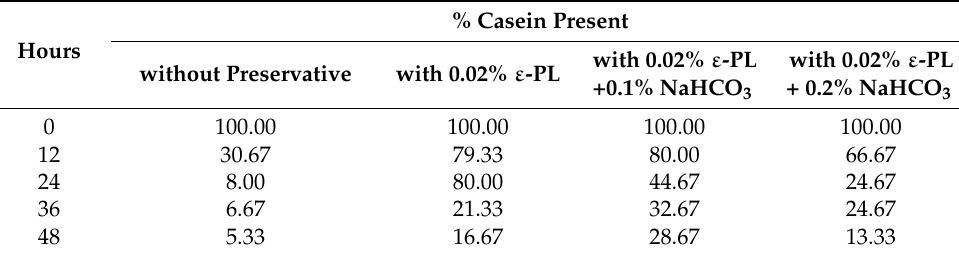
Table 5. Effect of ε -PL and sodium bicarbonate as the preservative on casein degradation.